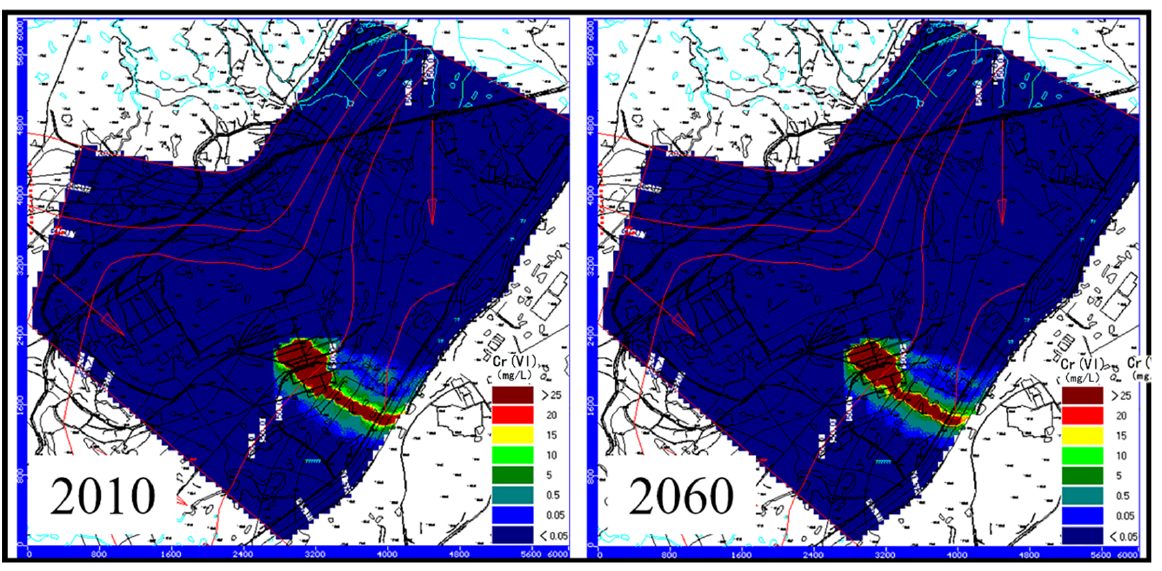
Figure 9. Simulation results for Cr(VI) in groundwater with heavy pollution (scenario IV).